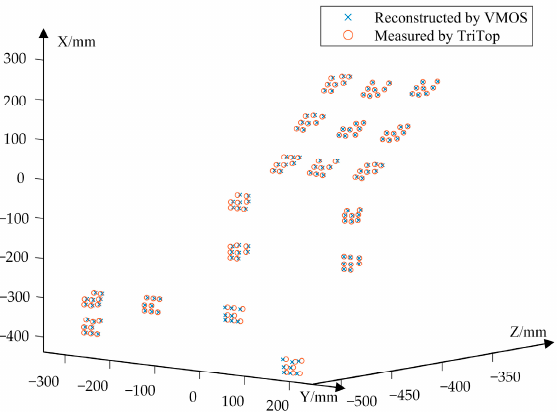
Figure 16. The points on the 3D structure reconstructed by the VMOS by TriTop ® . Table 4. Reconstruction errors of 19*8 coded points on the 3D object.